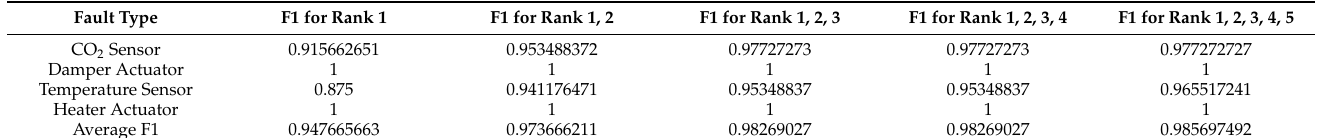
Table 27. F1 of diagnostic classifier in different cumulative ranks for different fault types.